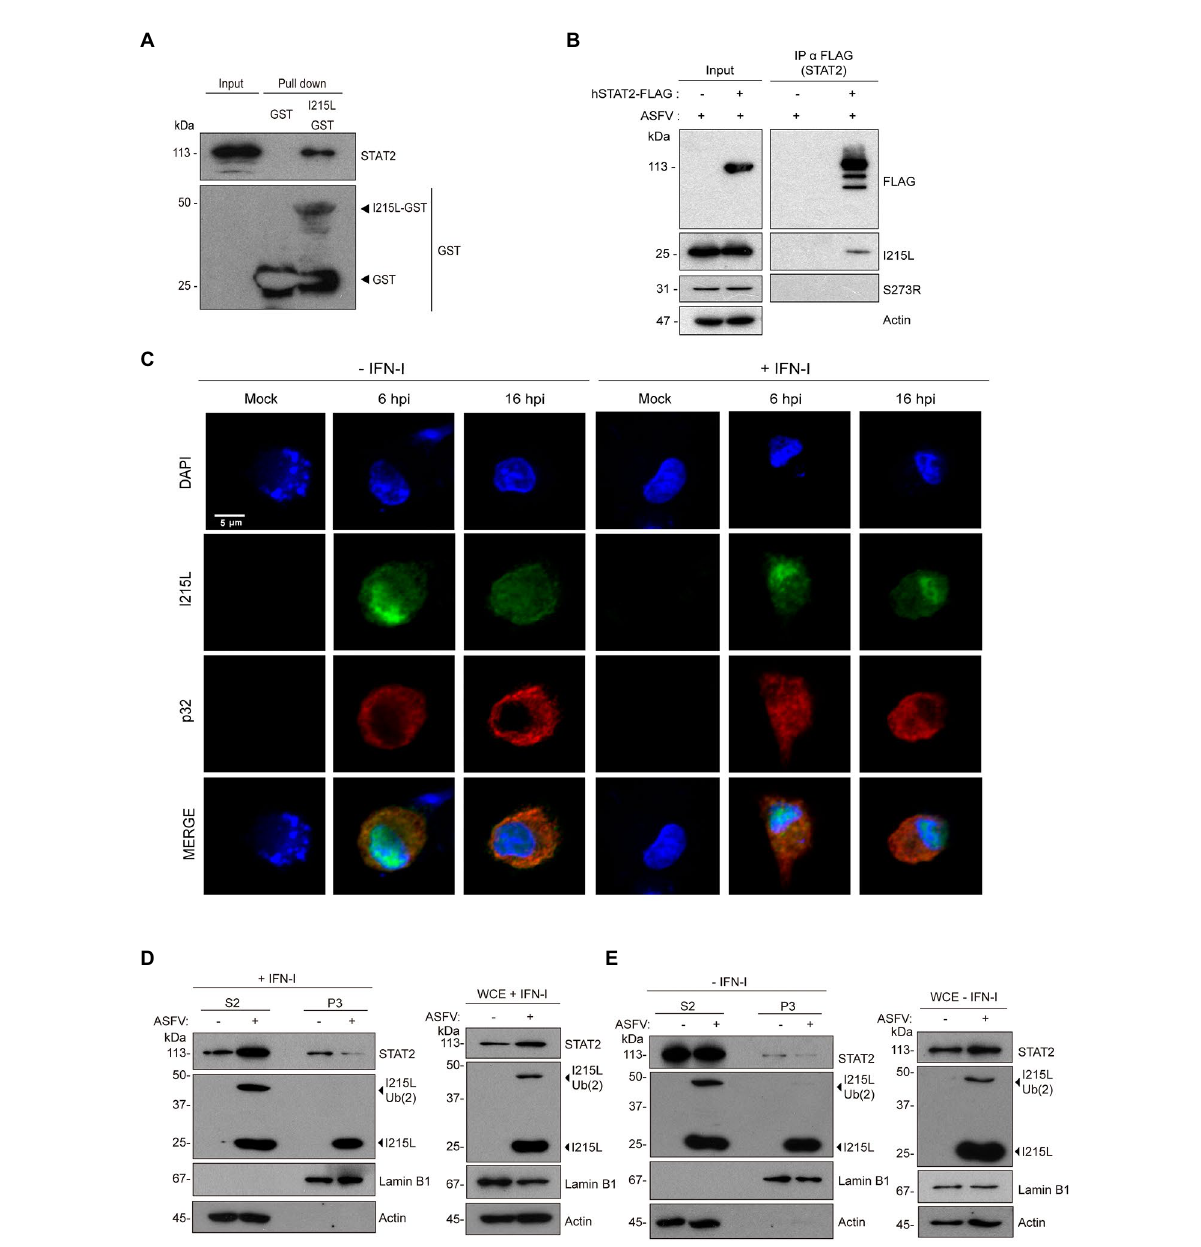
FIGURE 6 pI215L interacts with STAT2 and promotes its ubiquitination during infection in PAMs. (A) pI215L-GST interacts with STAT2 from extracts of infected PAMs by a pull-down assay. PAMs were infected with Arm/07/CBM/c2 (1 PFU/cell) harvested at 16 hpi and processed for the pull-down experiment with glutathione sepharose beads bound to pI215L-GST or to GST alone as a negative control. Bead-bound proteins were detected by Western blotting labeling with anti-STAT2 and anti-GST antibodies. (B) hSTAT2-FLAG-pI215L interaction during ASFV infection. COS-1 cells were transfected with hSTAT2-FLAG (0.4 μ g/1 × 10 6 cells) and infected with Arm/07/CBM/c2 (1 PFU/cell) for 16 h. Cells were then collected and processed for immunoprecipitation with an anti-FLAG antibody and analyzed by Western blot analysis labeling with antibodies against FLAG to detect STAT2, against pI215L, against pS273R (negative control of co-inmunoprecipitation) and against actin. (C) PAMs were mock infected or infected with Armenia/07/CBM/c2 (1 PFU/cell). At 5 or 15 hpi, cells were untreated or treated with universal type I IFN (250 U/mL). After 1 h of treatment, cells were fixed and stained with DAPI (blue), anti-pI215L (green) and anti-p32 (red) antibodies and examined by a confocal microscope. Individual and merged images of the different channels are shown. (D,E) Nuclear fractionation of mock-infected or infected PAMs at 16 hpi in presence (D) or in absence (E) of IFN-I (500 U/mL). PAMs were seeded in p60 plates and were mock infected ( − ) or infected (+) with Armenia/07/CBM/c2 strain (1 PFU/cell) for 16 h. At 15 hpi, cells were untreated or treated with type I IFN (500 U/mL) for 1 h. Then, cells were collected and nuclear fractionation was performed. The whole cell extract (WCE), cytoplasmic fraction (S2) and nuclear chromatin fraction (P3) were analyzed by 10% SDS-PAGE, followed by immunoblotting with anti-STAT2 and anti-I215L antibodies. As controls of the fractionation, antibody against nuclear lamin B1 and antibody against cytoplasmic actin were